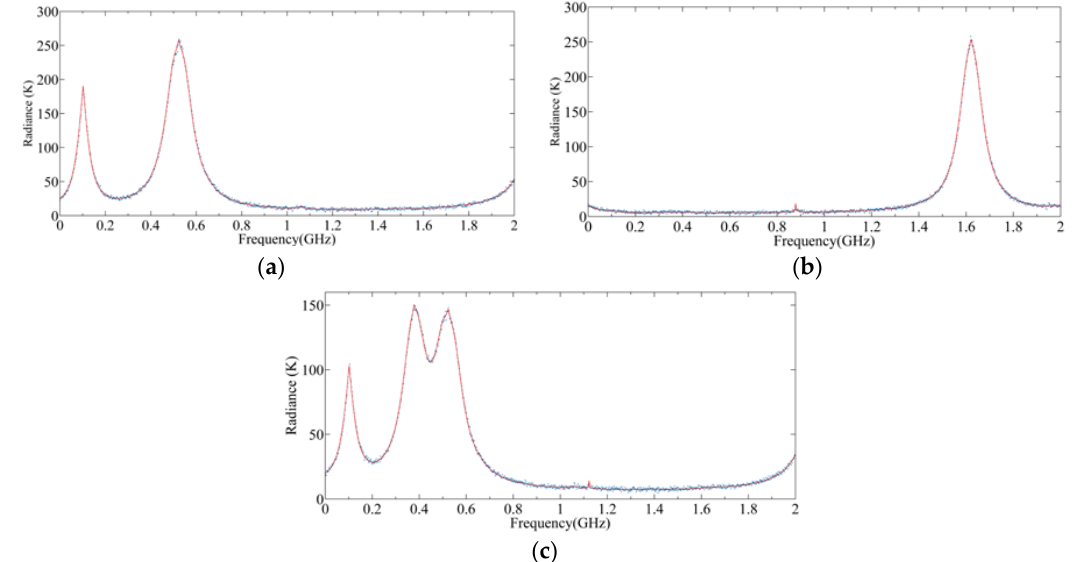
Figure 14. Radiance spectrum of single sideband (SSB) and double sideband (DSB): ( a ) Upper sideband; ( b ) lower sideband; ( c ) DSB.